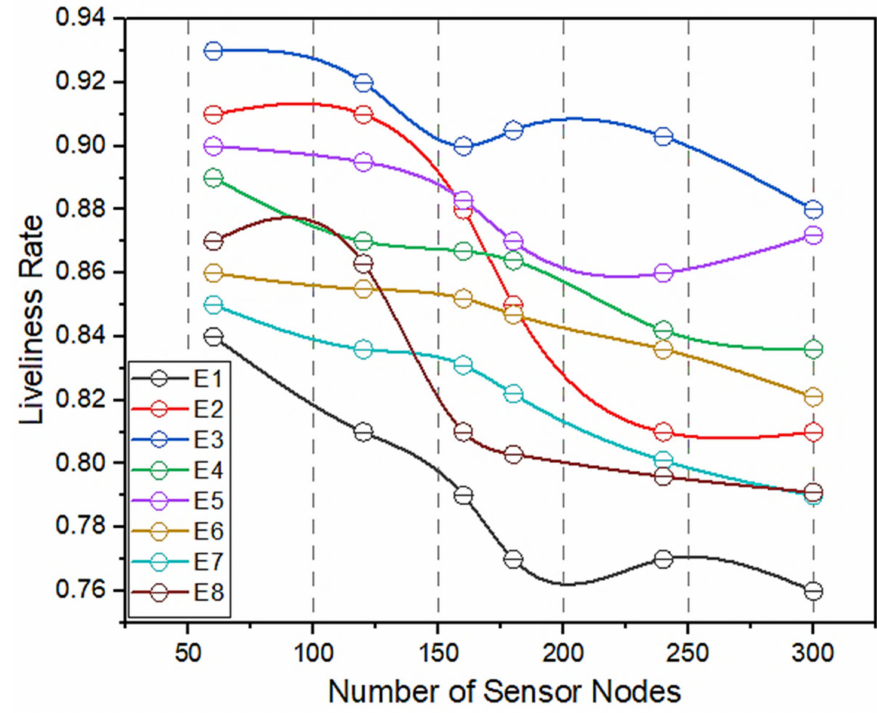
Figure 9. Average liveliness rate of sensor